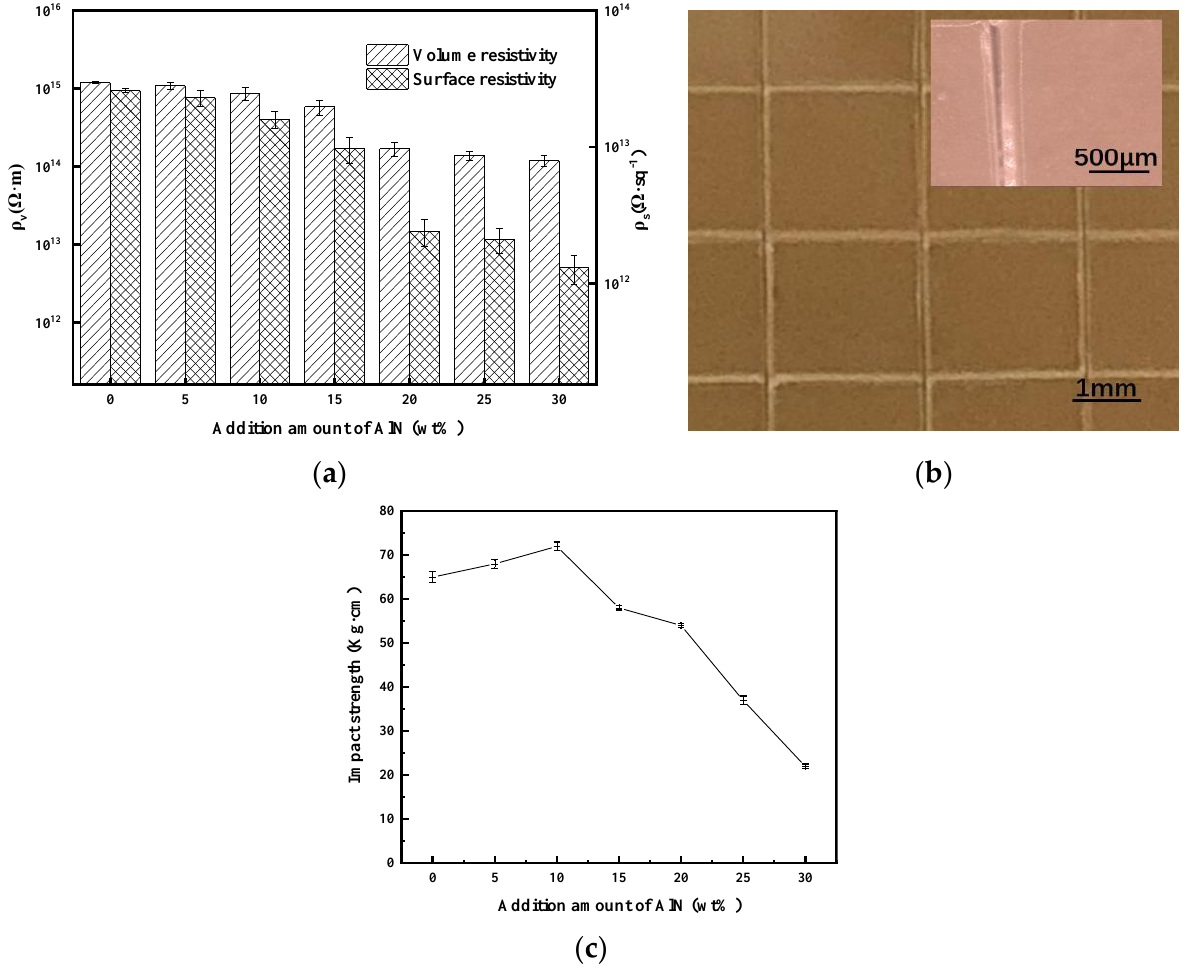
Figure 7. ( a )The surface resistivity and volume resistivity of the AlN/DG-ER sheet, ( b ) a photograph of the surface of the notches in the AlN/DG-ER coating (inset: SEM image) and ( c ) the impact strength of the AlN/DG-ER coating.